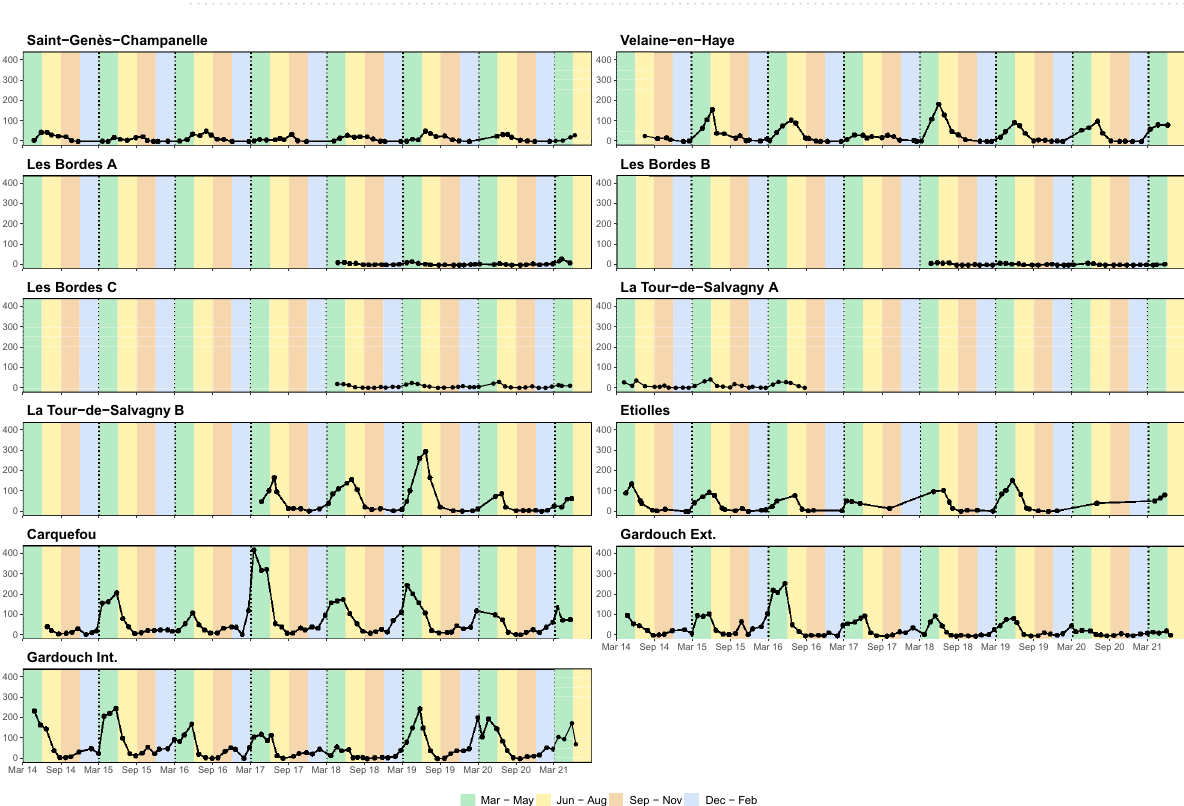
Figure 4. Number of Ixodes ricinus nymphs per 100 m 2 obtained from 11 sampling sites. Background colours indicate meteorological seasons of temperate areas of the northern hemisphere: Spring, 1st March to 31st May (green); Summer, 1st June to 31st August (yellow); Autumn, 1st September to 30th November (brown); Winter, 1st December to 28th or 29th February (blue). Vertical dashed lines indicate 1-year